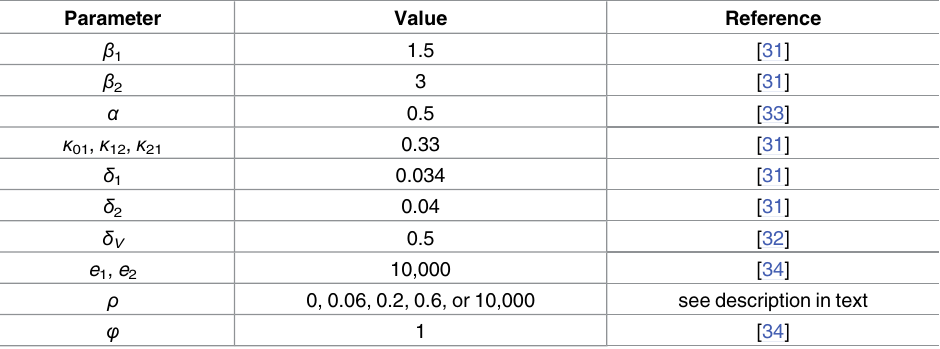
Table 2. LPAI simulation model parameters, values, and references.